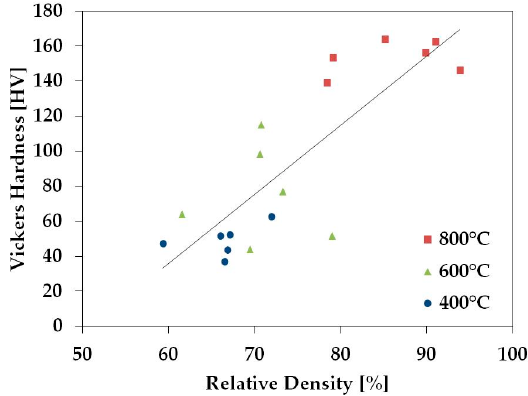
Figure 7. Average Vickers harness values for TNZT samples sintered at different temperatures (red square 800 °C, green triangle 600 °C, and blue circle 400 °C) without holding time and their relation to relative density.